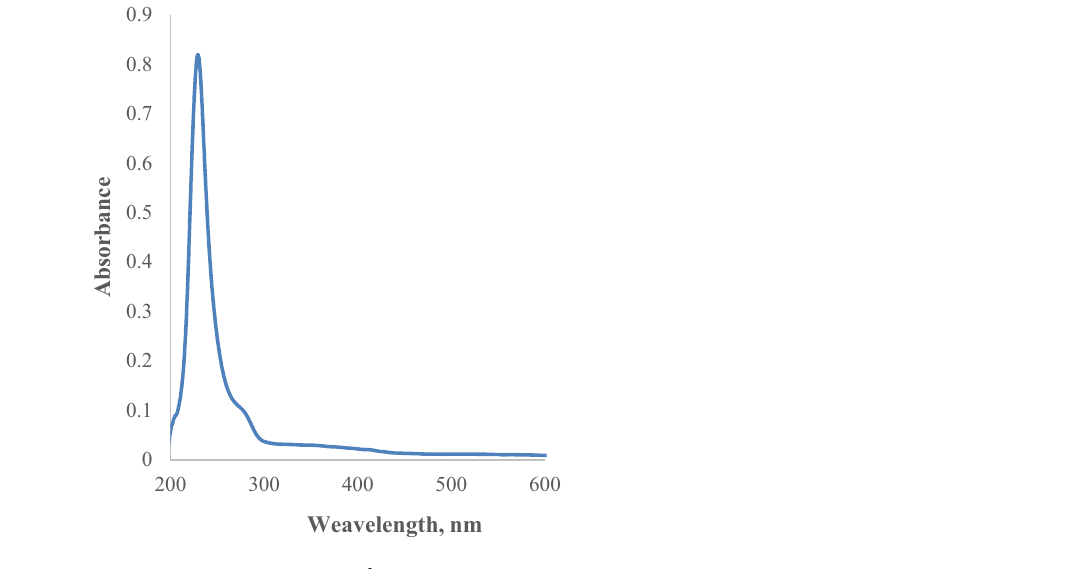
Figure 4. UV–Vis spectrum of ORF3a in PBS at pH =